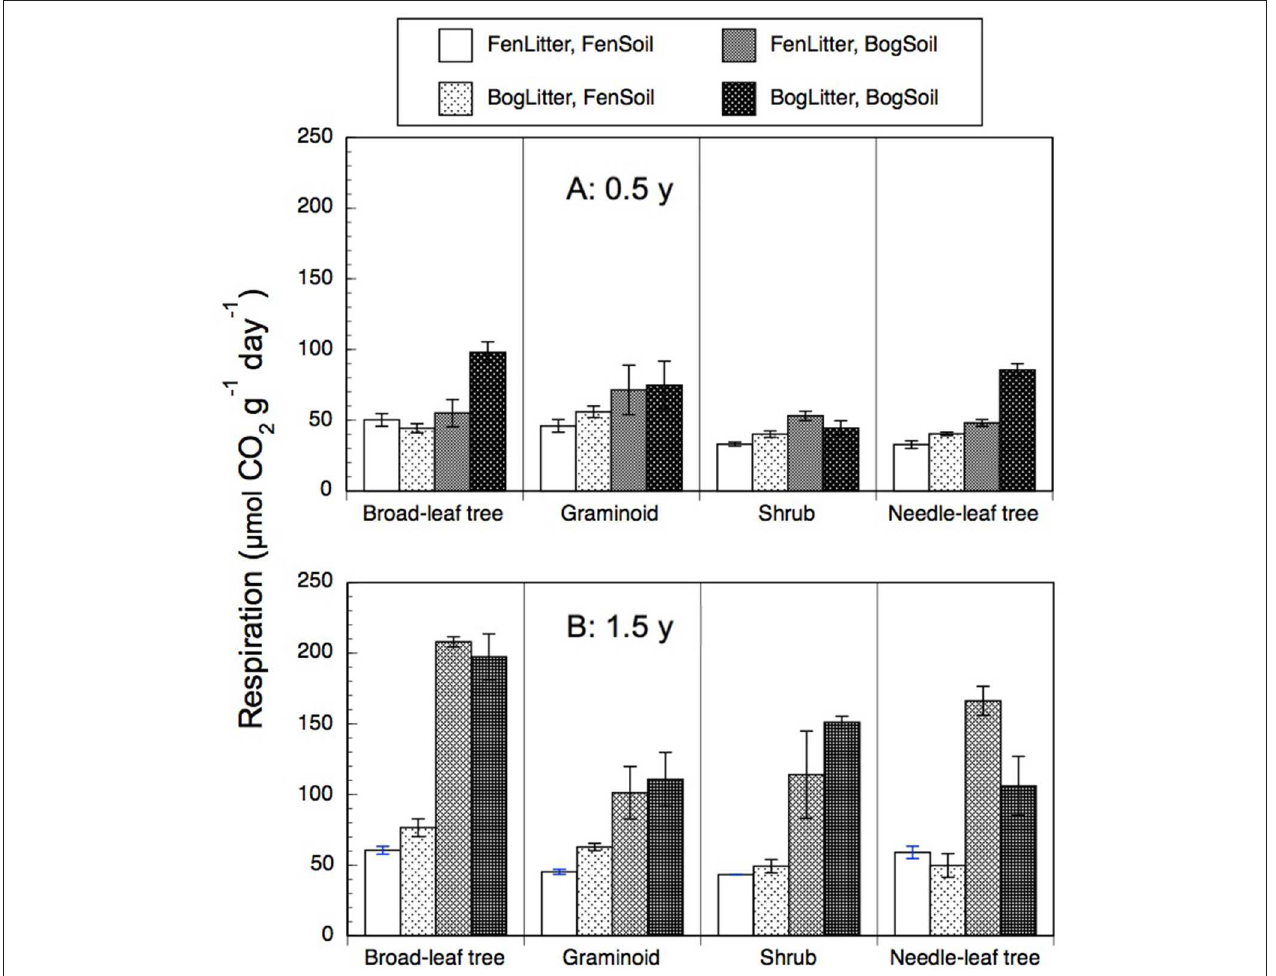
FIGURE 5 | Rates of anaerobic respiration ( µ mol CO 2 g − 1 dry residue d − 1 ) by leaf litter residue from four plant growth forms having decayed in bogs or in rich fens ( A : 0.5 year, B : 1.5 years) mixed with peat soil from a bog or rich fen. Values are mean + standard error; n = 4 per plant growth form, 6 for needle-leaf trees.